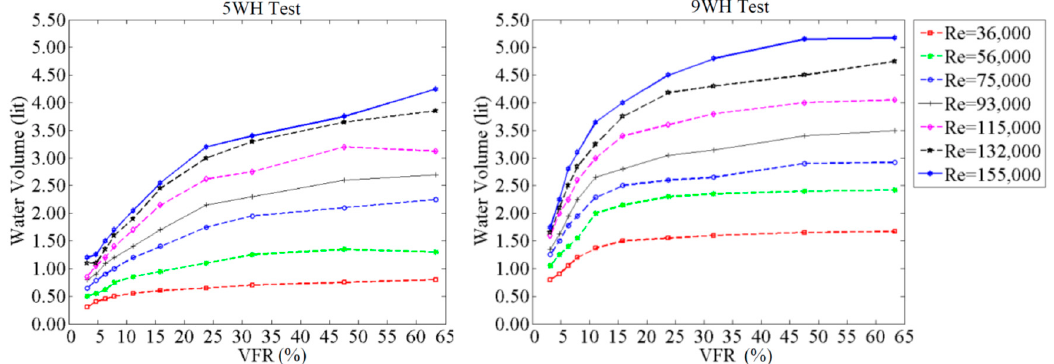
Figure 13. Discharged water volume against the VFR for different Re and WH events.